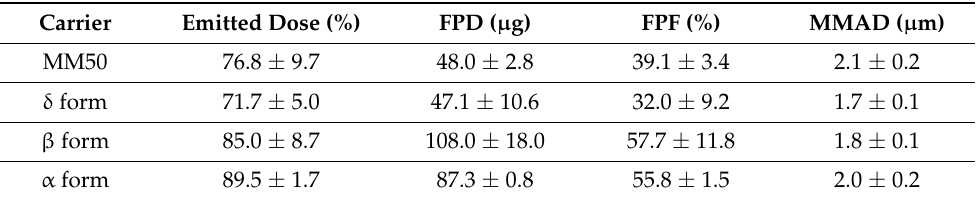
Table 6. Deposition profiles of budesonide from MM50, α , β and δ in an ACI after aerosolization with NESAT at 48 L min − 1 [Mean (SD), n =